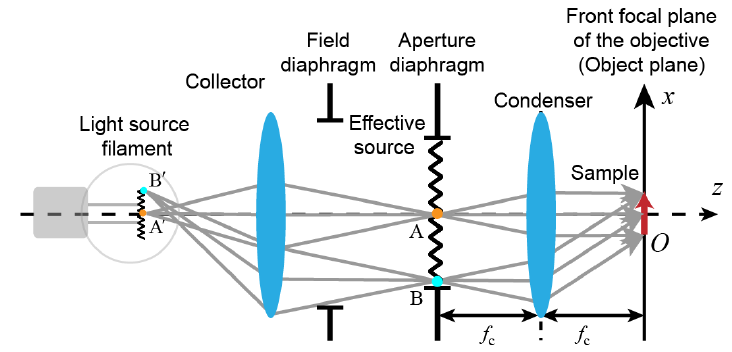
Figure 1. The optical path of Köhler illumination.